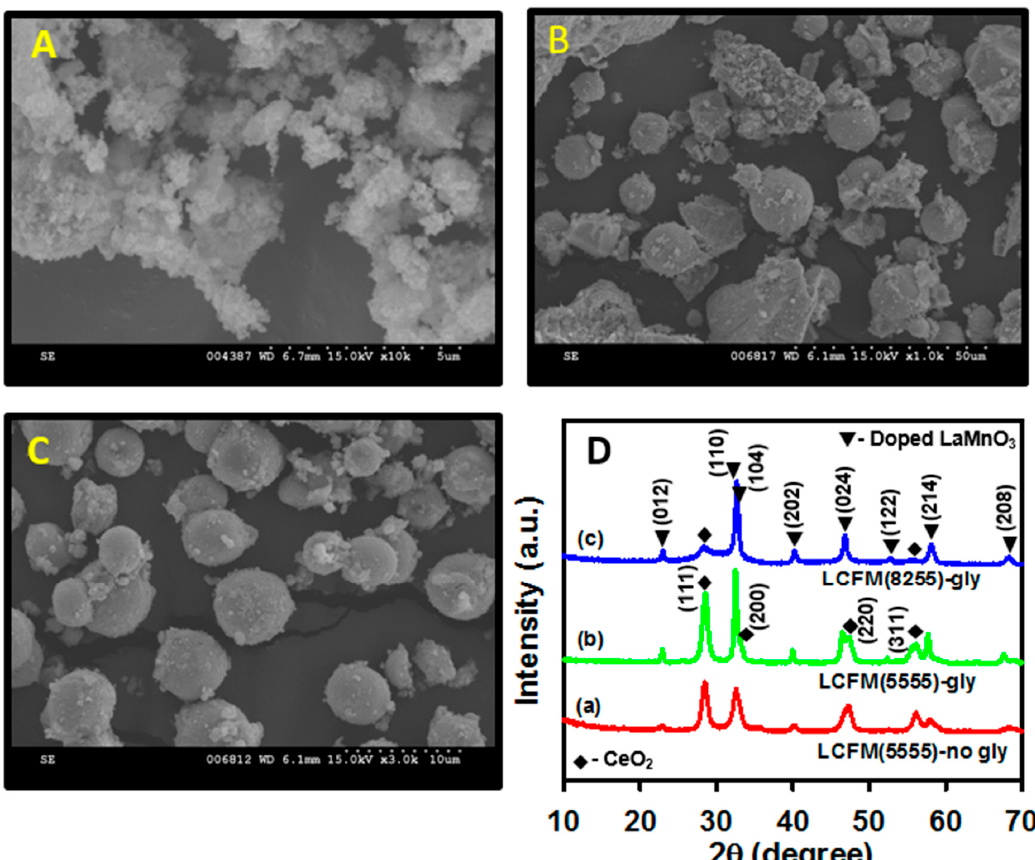
Figure 1. SEM images of ( A ) LCFM(5555)-no gly, ( B ) LCFM(5555)-gly and ( C ) LCFM(8255)-gly. ( D ) XRD patterns of ( a ) LCFM(5555)-no gly, ( b ) LCFM(5555)-gly and ( c ) LCFM(8255)-gly.